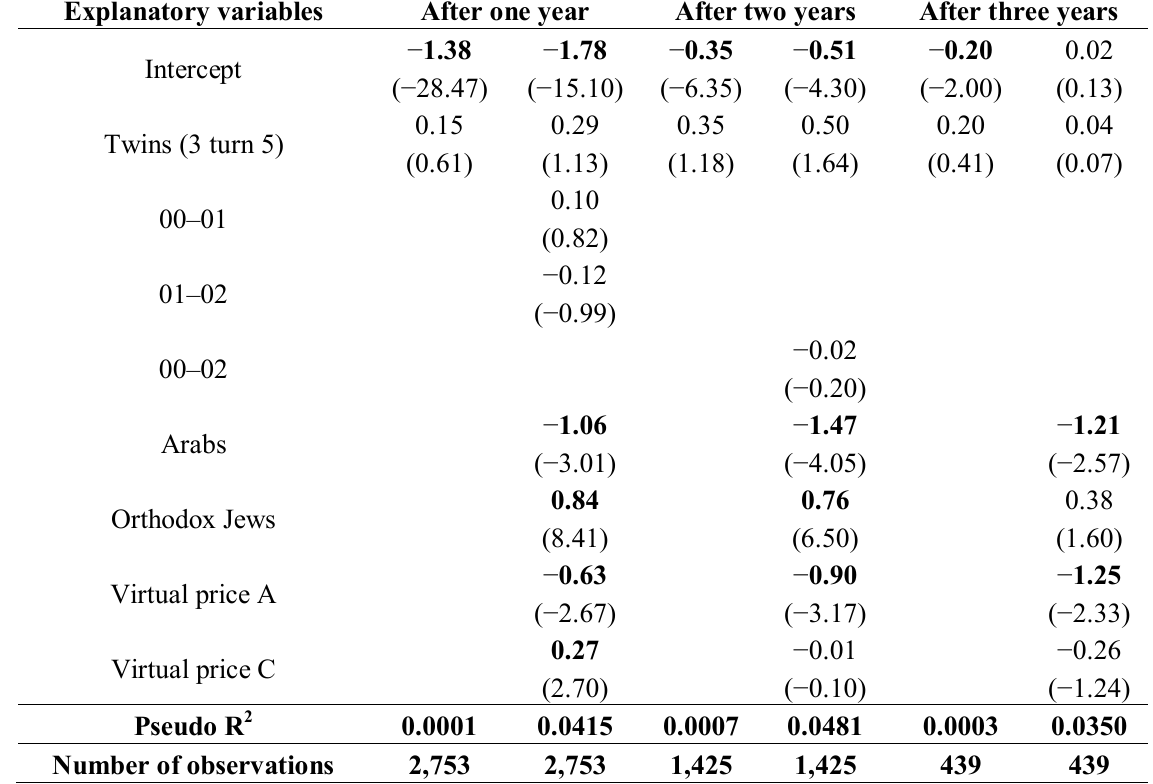
Table 5. Effect of administrative costs on take-up rates—robustness test: Logit estimation. (Dependent variable: reporting status in year